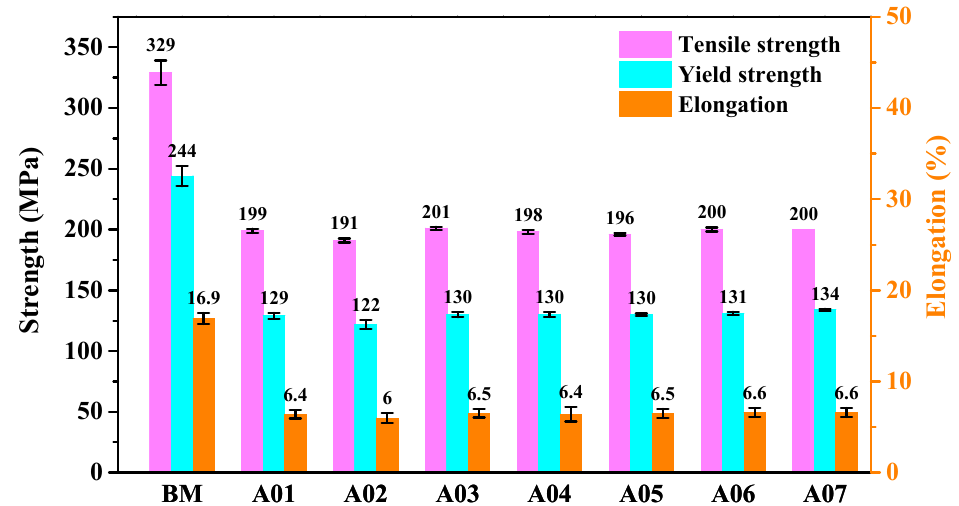
Figure 8. Tensile properties of the base metal and specimens A01–A07. The tensile strength, the yield strength and the elongation of specimens A01–A07 were weaker compared to the base metal. The average tensile strength, the yield strength and the elongation of specimens A01–A07 were 198 MPa, 129 MPa and 6.4%, respectively, which were 60.2%, 52.9% and 37.9% of the base metal. In particular, when ∆ I b was 20 A, the tensile properties of specimen A02 were the weakest among the specimens A01–A07. The tensile strength, the yield strength and the elongation of specimen A02 were 191 MPa, 122 MPa and 6.0%, respectively and only 58.1%, 50.0% and 35.5% of the base metal. This result could be due to the distribution of pores in Table 4 and Figure 6. When ∆ I b was 20 A, the number of middle pores and big pores in the weld was the greatest, which reduced the actual cross-sectional area of the weld and weakened the tensile properties of the joint. The tensile strength, the yield strength and the elongation of specimen A05 were 196 MPa, 130 MPa and 6.5%, respectively, which were slightly greater than those of specimens A01–A07. Therefore, the tensile properties of specimens A01–A07 were similar to the absorbed energy results. At the same time, it was noted that when ∆ I b was 10 A, 30 A, 40 A, 50 A, 60 A and 70 A, the weld formation was beautiful, and the absorbed energy, the yield strength, tensile strength and elongation of the welded joints were fine and changed little. These results indicate that changing ∆ I b was suitable for DP-GMAW with a wide matching range. Namely, ∆ I b could realize stable DP-GMAW welding in a large variation range; meanwhile, the joints had excellent mechanical properties. After the tensile test, the fracture morphology of specimens A01–A07 was tested by a scanning electron microscope. The specific results are shown in Figure 9. It can be seen that the SEM fracture section of the tensile sample was distributed with a large number of small and deep dimples. Meanwhile, some inclusions or second-phase particles were clearly observed at the bottom of the dimples and there was no significant difference in the size of the dimples between the different samples. The above SEM results indicate that the fracture mode of the joint was a ductile